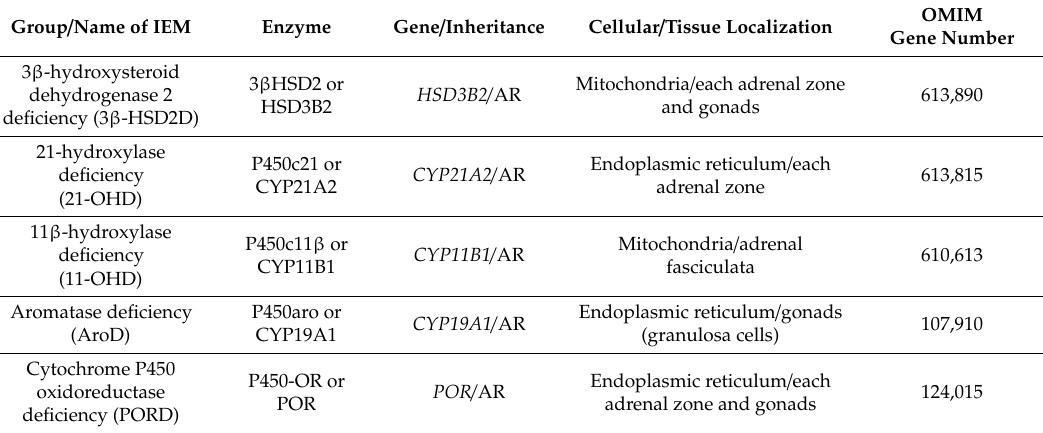
Table 1. Disorders of steroid metabolism that cause androgen excess (Modified from